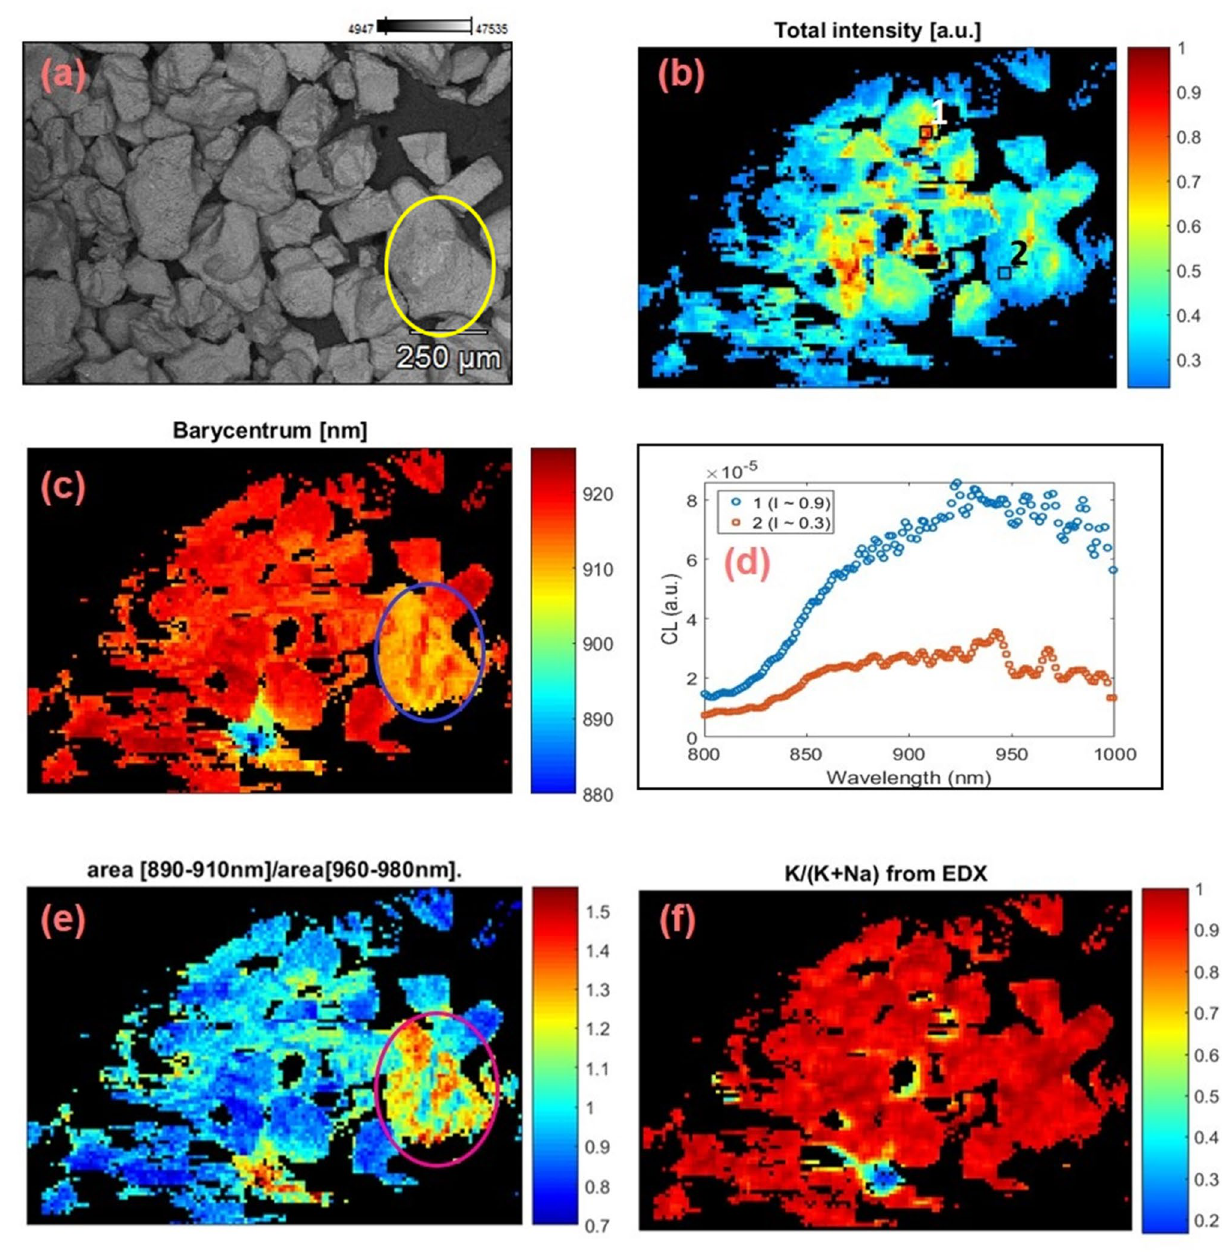
Figure 2. CL and elemental data (CL-EDX) for sample R47. ( a ) Backscattered electrons (BSE) image, ( b ) cathodoluminescence intensity map; the intensity below a normalized value of 0.235 I max has been filtered out using a mask, ( c ) barycenter map in the range 880–925 nm, ( d ) local CL spectra of two regions at intensities, I ≈0.9 I max and ≈0.3 I max on the intensity map (square labeled regions 1 and 2 in b ), ( e ) relative concentration map of the K-content (K/K + Na), and ( f ) intensity ratio map between the two NIR bands (890–910 nm and 960– 980 nm). Circled grain shows the variation in IRCL emission within the grain. These images were generated using Matlab (Version: R2016, Url: https ://www.mathw orks.com/produ cts/matla